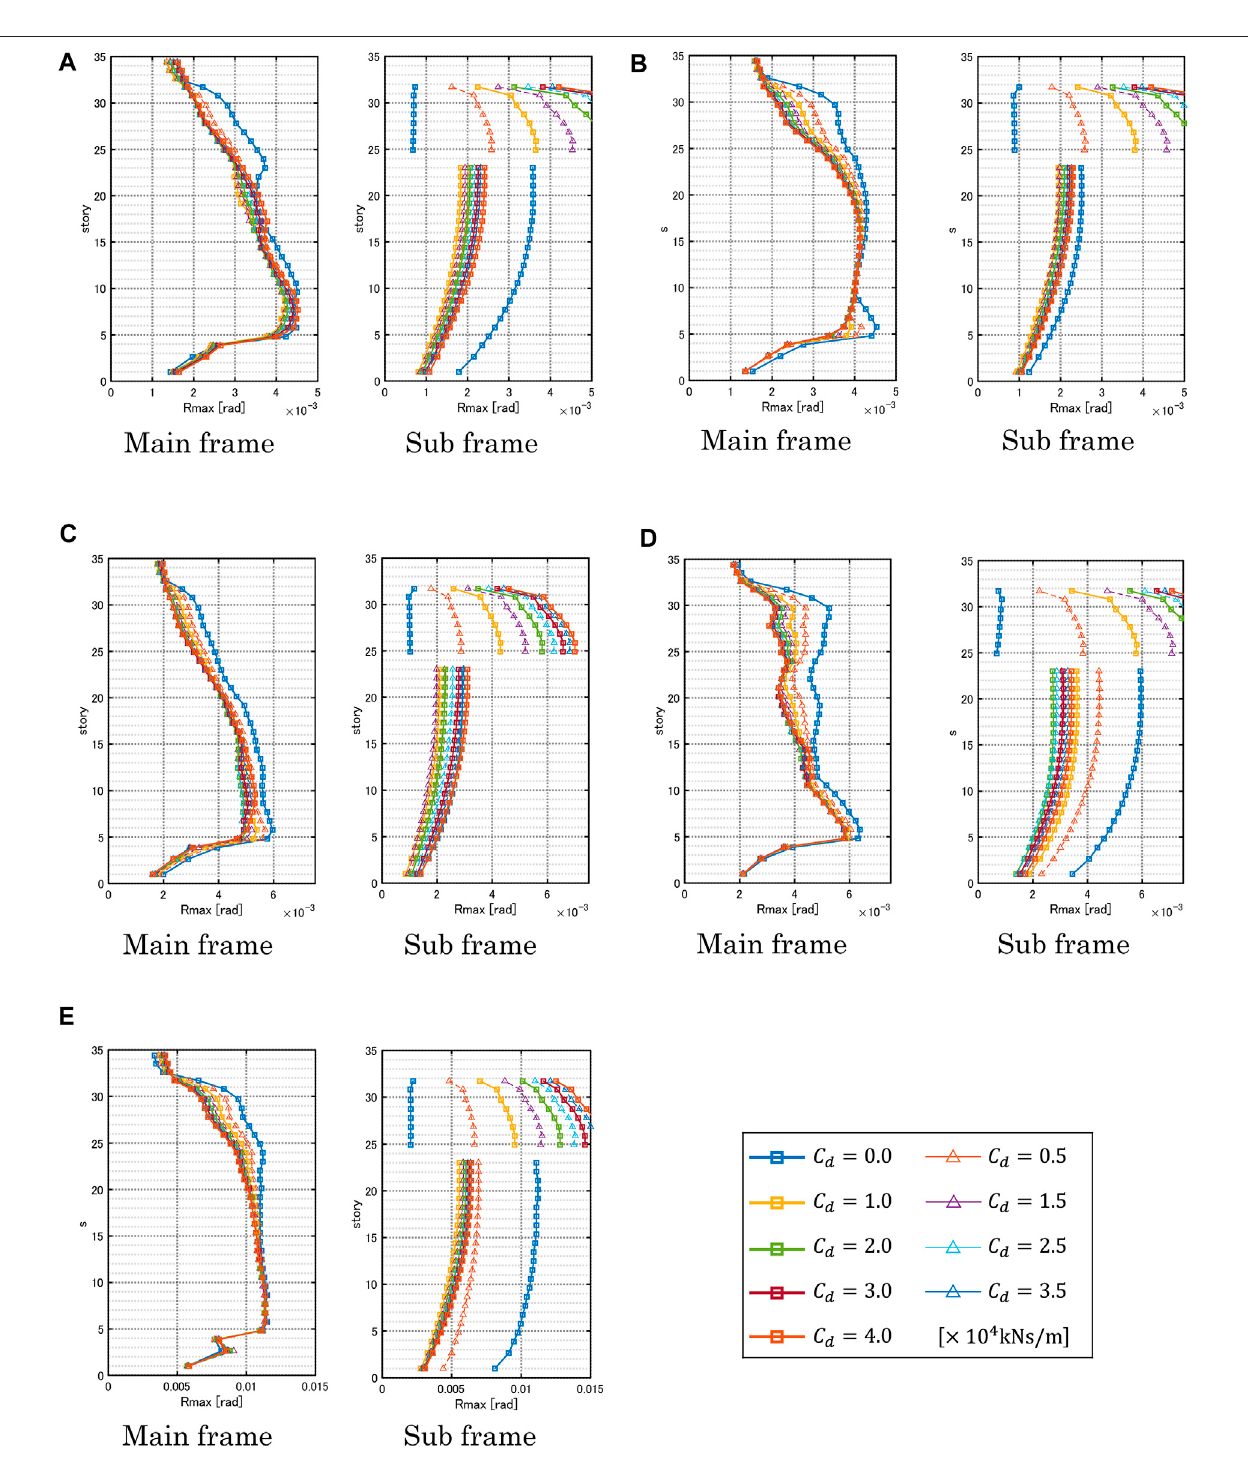
FIGURE15| Maximuminterstorydriftsofbuildingswithnine-leveldampersfor fi verecordedgroundmotions, (A) ElCentroNS, (B) TaftEW, (C) HachinoheNS, (D) JMA Kobe NS, (E) Rinaldi Station FN.